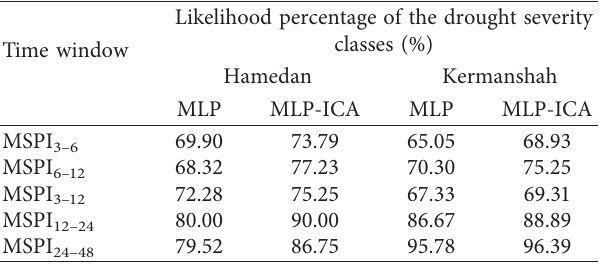
Table 5: The models’ likelihood in determining MSPI drought classes. Likelihood percentage of the drought Time window